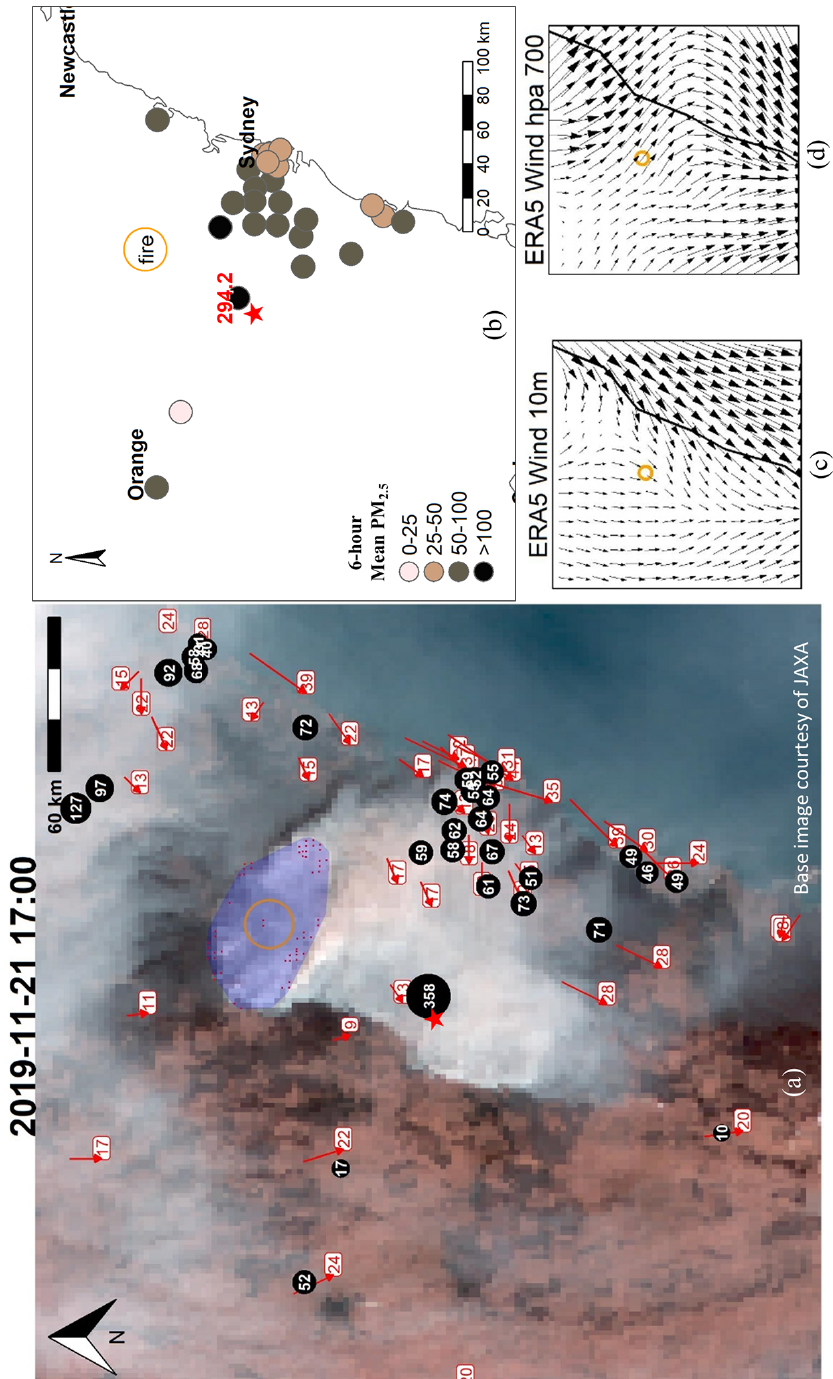
Figure A1. Wildfire afternoon. The largest afternoon mean WF PM 2 . 5 was 294.2µgm − 3 at Katoomba AQS, which was the third closest to fire. The fire (Gospers Mountain) eventually burnt ∼ 500000ha. A total of 15 other AQSs around the fire had mean PM 2 . 5 > 50. The smoke was flowing mainly to the south over Katoomba (red star) under the surface northerly winds. However, a portion of the smoke was also flowing more easterly with upper-level winds. There is a distinct easterly edge to the smoke plume (a) , which appears to align with where the northerly and north-easterly surface winds meet (c) . There were widespread PM 2 . 5 exceedances, but only Katoomba recorded values > 150µgm − 3 (b) . Smoke from other wildfires to the north of Sydney may have affected the region, indicated by the AQS north of the Gospers fire also recording high PM 2 . 5 values (a) . These AQSs are not shown in (b) because they were within 150km of more than one active fire. In the morning before this image, smoke was flowing directly into Sydney and most AQSs recorded at least one hourly value > 200µgm − 3